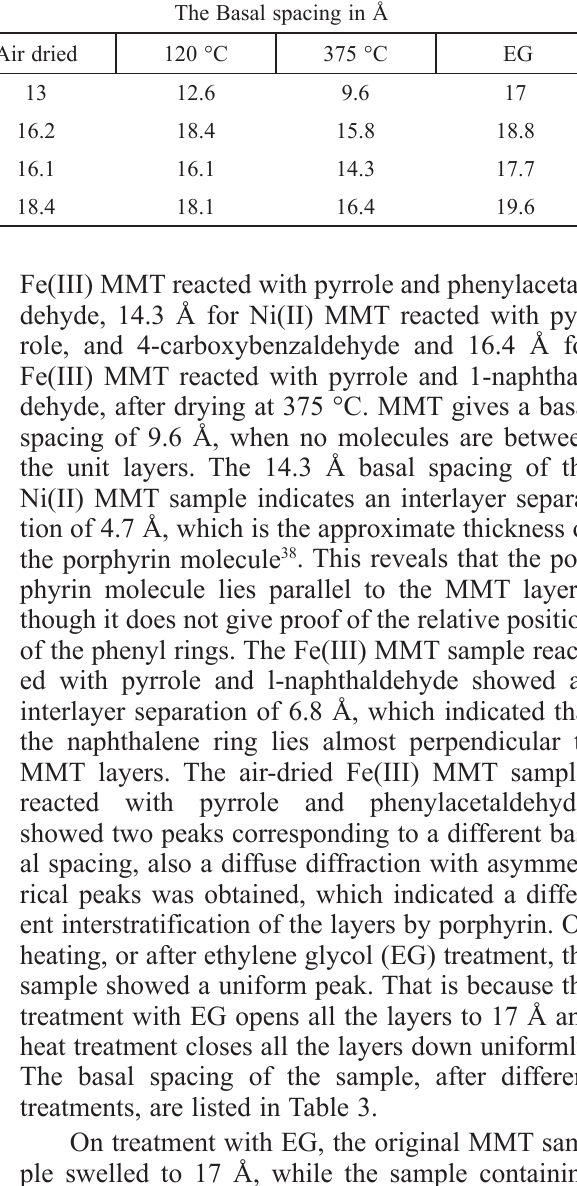
Table 3 – Basal spacing of MMT samples reacted with pyrrole and different aldehydes Samples